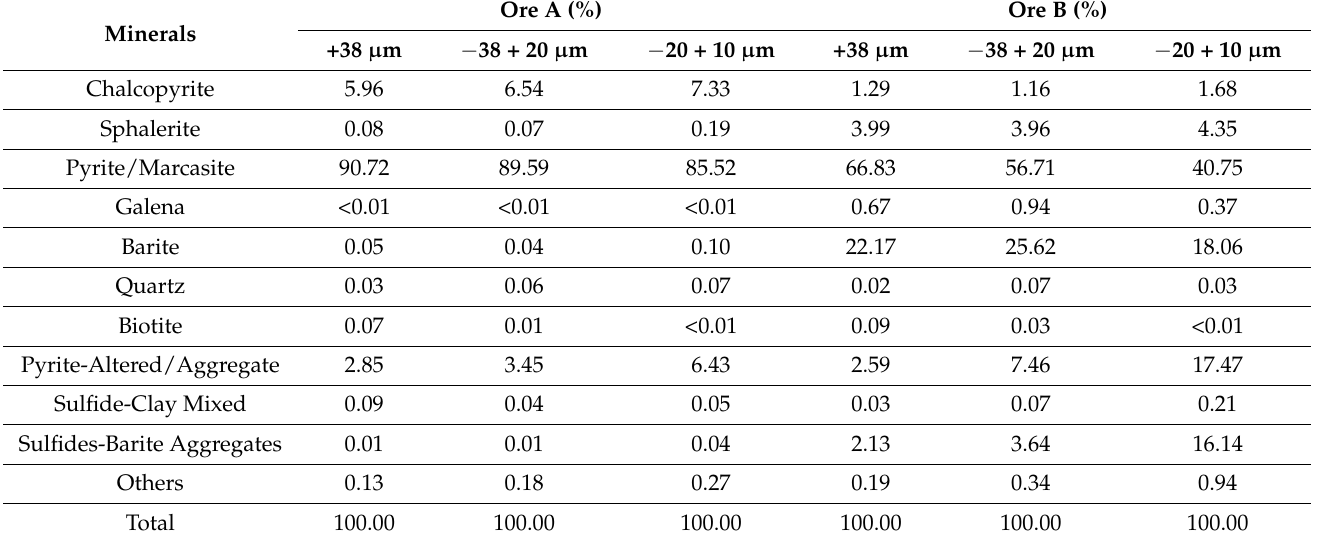
Table 4. Modal mineralogy of Ore A and Ore B on size-by-size basis.